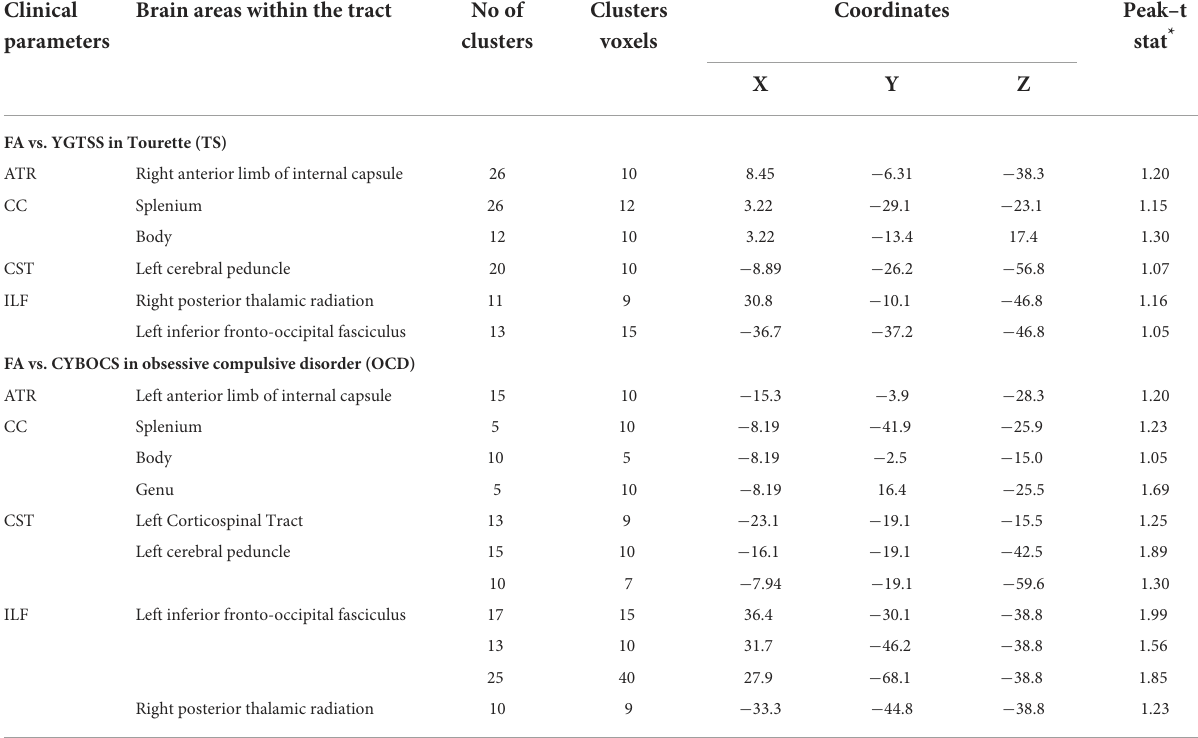
TABLE 3 Brain areas within white matter tracts showing significant correlations between fractional anisotropy (FA) and clinical data.